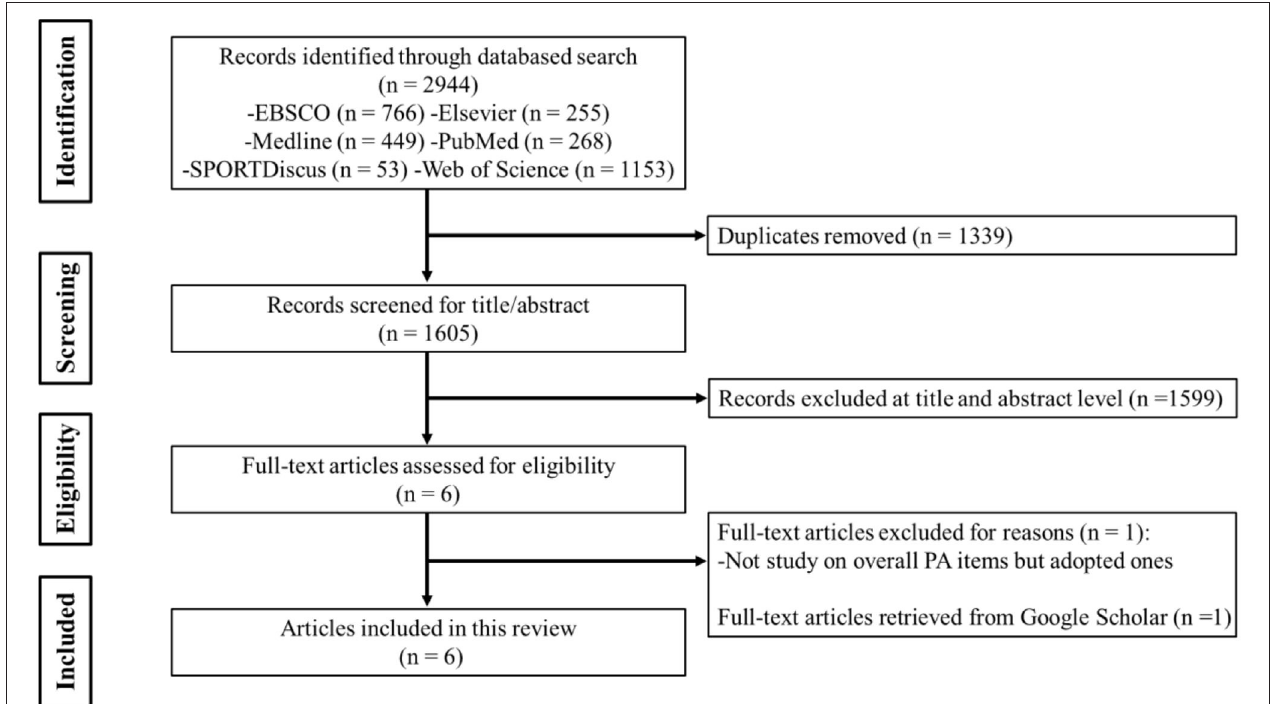
FIGURE 1 | Flow chart of literature